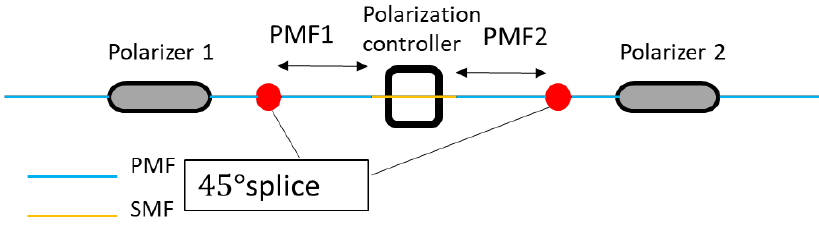
Figure 2. Configuration of wavelength tunable spectral filter based on birefringent fibers. Polarizer 1 was spliced with PMF1, which was inclined by 45 degrees. For the output port, polarizer 2 was spliced with PMF2 which was also inclined by 45 degrees. A SMF